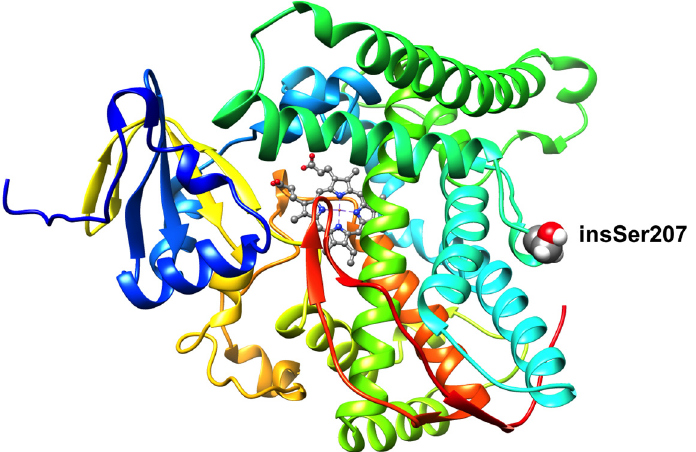
Fig 6. Structural model of human CYP4B1 with insSer207 located in a loop region from G198 to S210. Cartoon representation of the structure of human CYP4B1. The side chain of insSer207 and the heme prosthetic group are shown as spacefilling and ball and stick representations, respectively. Carbon atoms are colored gray, oxygen atoms are colored red, nitrogen atoms are colored blue, and hydrogen atoms are colored white. The figure was generated using UCSF Chimera